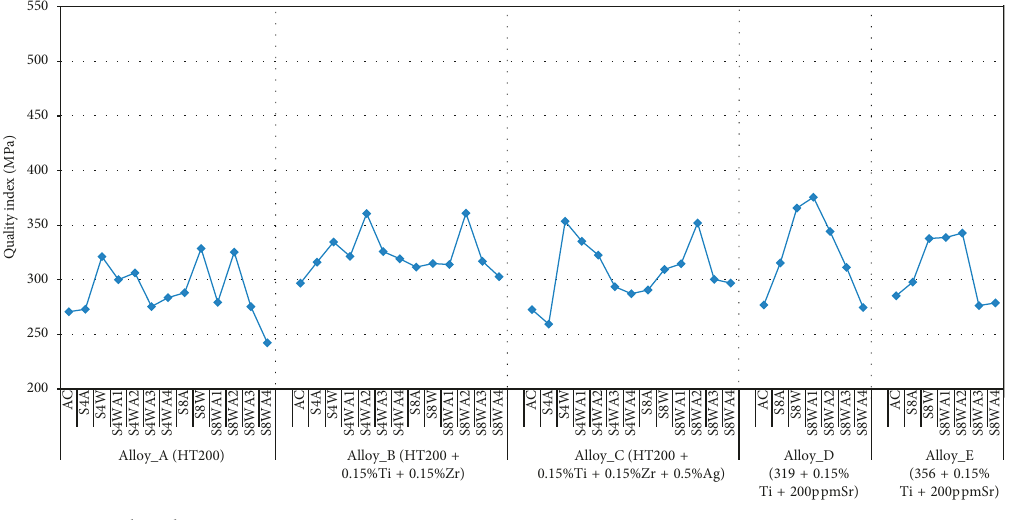
Figure 14: A panel chart for the quality values of alloys A, B, C, D, and E in the as-cast condition and the 12 heat-treatment conditions used in this